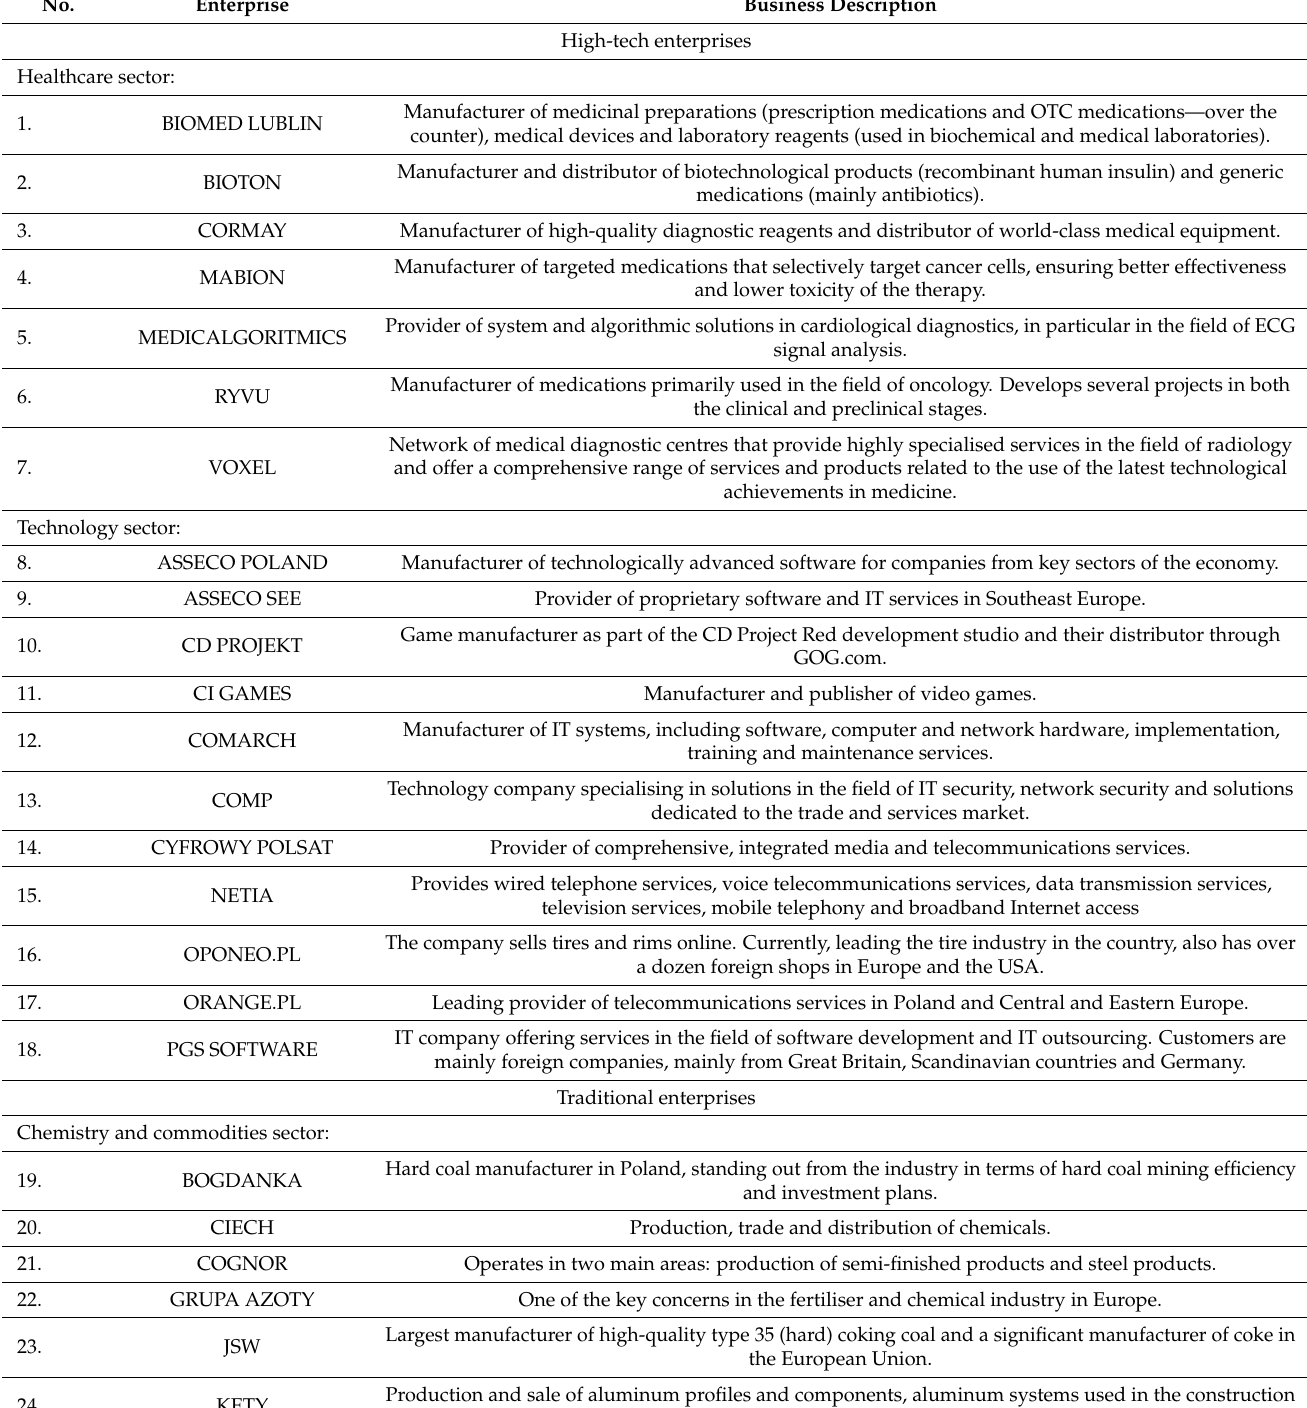
Table A1. Characteristics of the surveyed